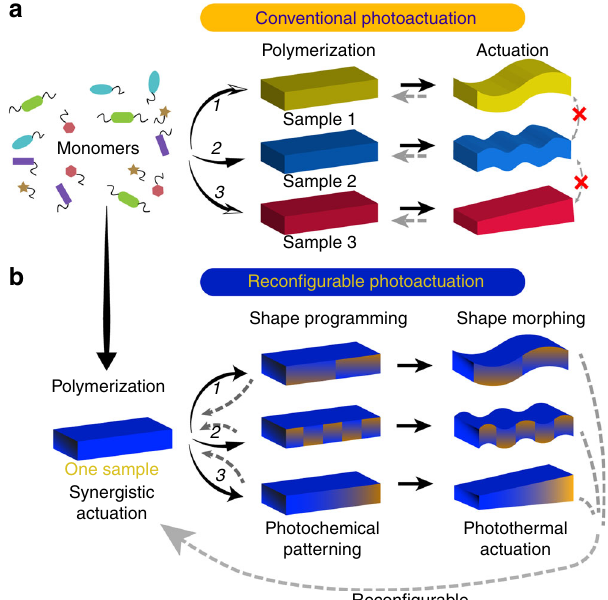
Fig. 1 Actuator concept. a Conventional stimuli-responsive actuators require a programming process in fabrication which eventually results in different samples with distinct actuation modes. b A recon fi gurable photoactuator capable of multiple shape changes from one single sample upon one identical stimulus is achieved using photochemical trigger for shape programming and photothermal effect for shape